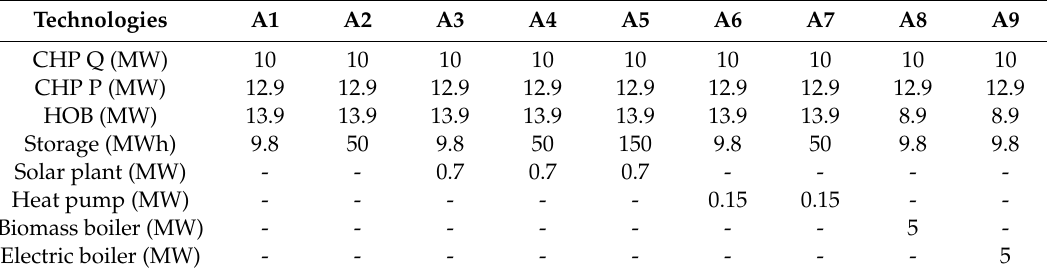
Table 3. Production capacities for the di ff erent